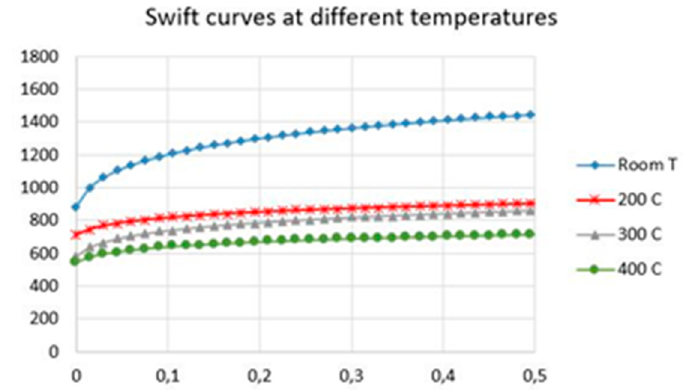
Figure 5. Swift models corresponding to tensile behavior of Ti6Al4V alloy at different temperatures.